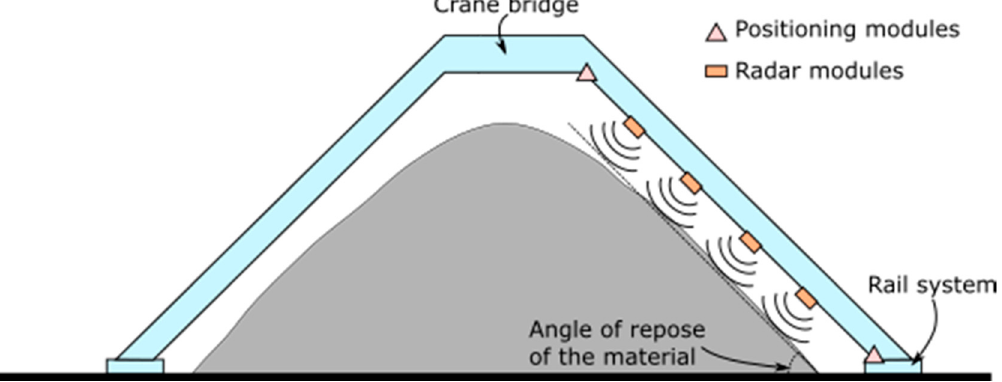
Figure 1. Side-view of the proposed system embedded into the crane-bridge of a stockpile management system.